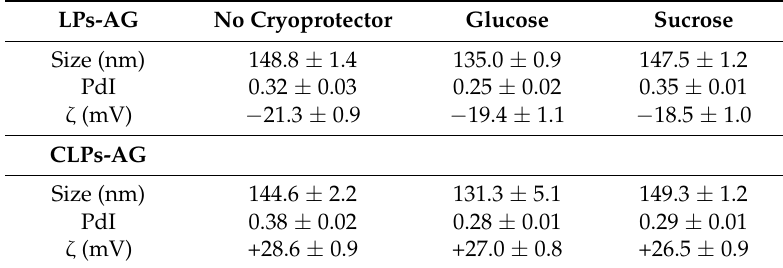
Table 2. Physical parameters of andrographolide loaded liposomes, after the freeze-drying process with and without cryoprotectant, 1% w / v of sucrose or glucose.